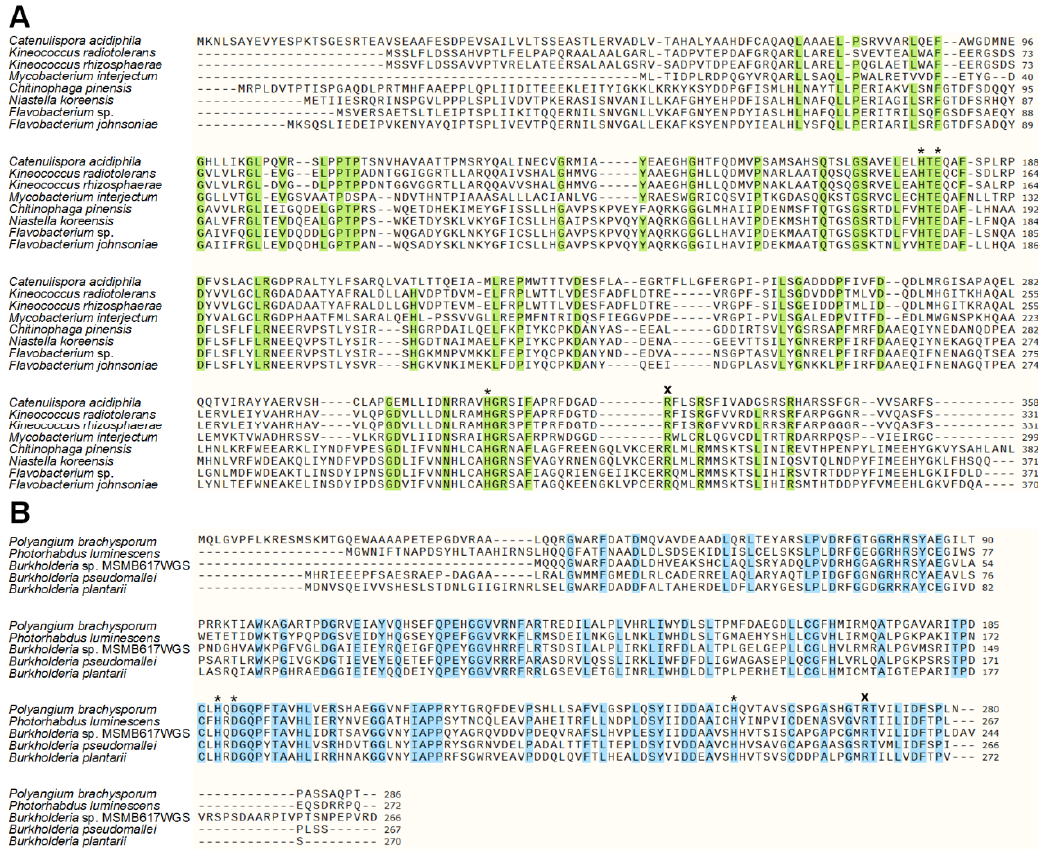
Figure 3. ( A ) Multiple sequence alignment of the KDO from Catenulispora acidiphila ( Caci KDO) with homologs from different species. ( B ) Multiple sequence alignment of the KDO from Polyangium brachysporum ( Bpra KDO) with homologs from different species. Shading indicates a consensus sequence above a threshold of 80%. The alignment was generated using MUSCLE (SnapGene ®® , GSL Biotech LLC, Chicago, IL, USA, Version 4.3.11). The asterisk depicts the three amino acids, which form the metal binding triad. The x denotes the arginine, which is involved in α -ketoglutarate ( α -KG) binding. Positions were adopted from crystal structures and homology models [9,19].